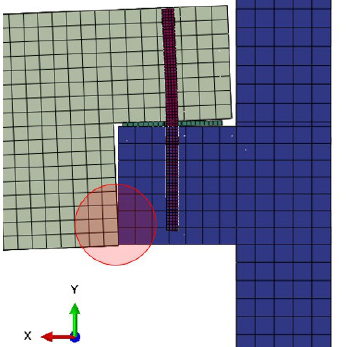
Figure 11. Contact between the half-joint and the corbel.